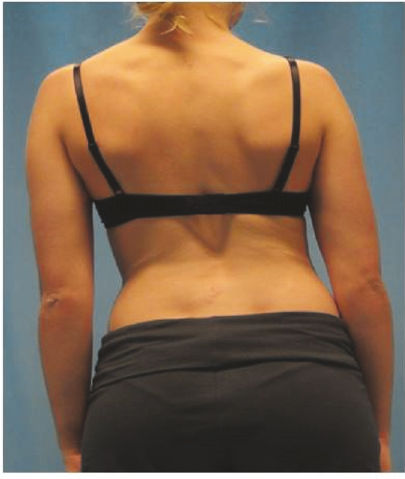
Figure 3: A person with a left LS from the posterior